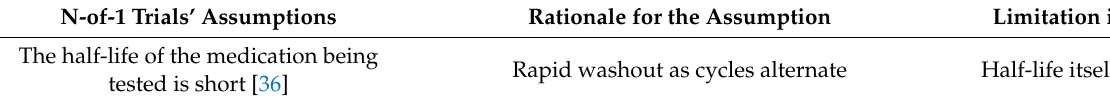
Table 2. Assumptions of N-of-1 trials (as research) and their limitations in pediatric